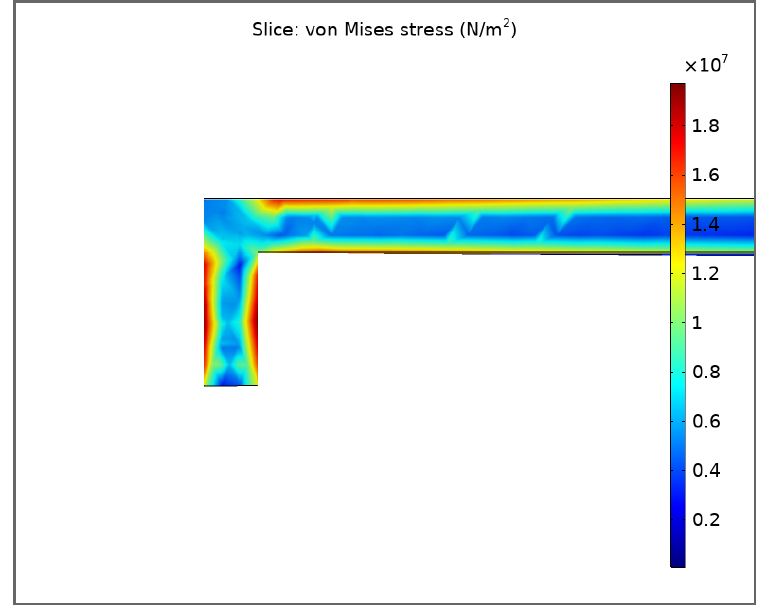
Figure 8. Mechanical stresses at 300 nm